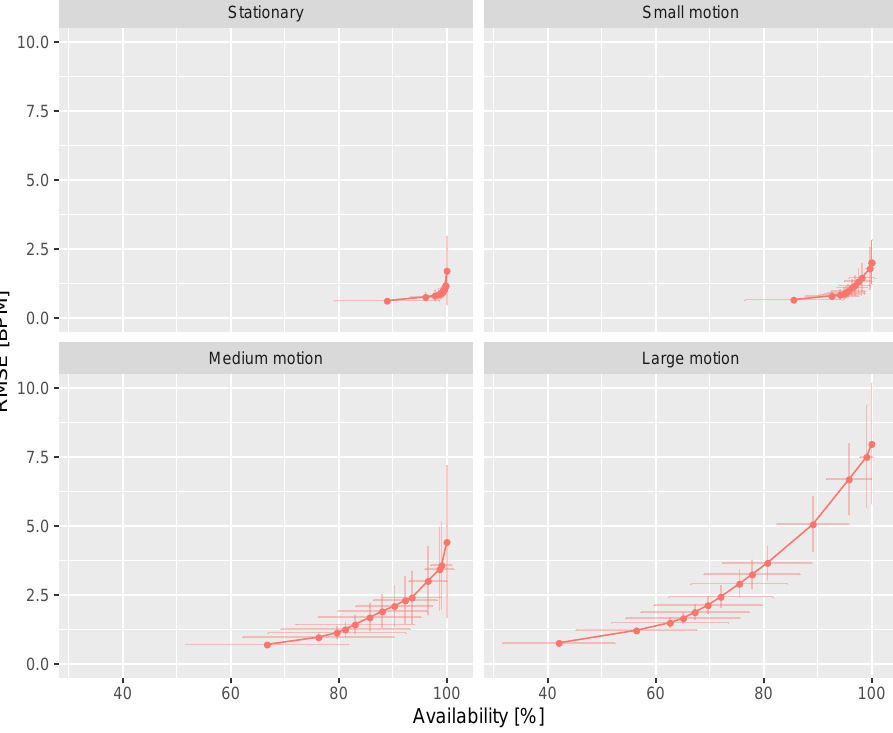
Figure 10. ROC curve of DIS in four categorized scenarios of the benchmark dataset. The plotting conventions are equal to those in Figure